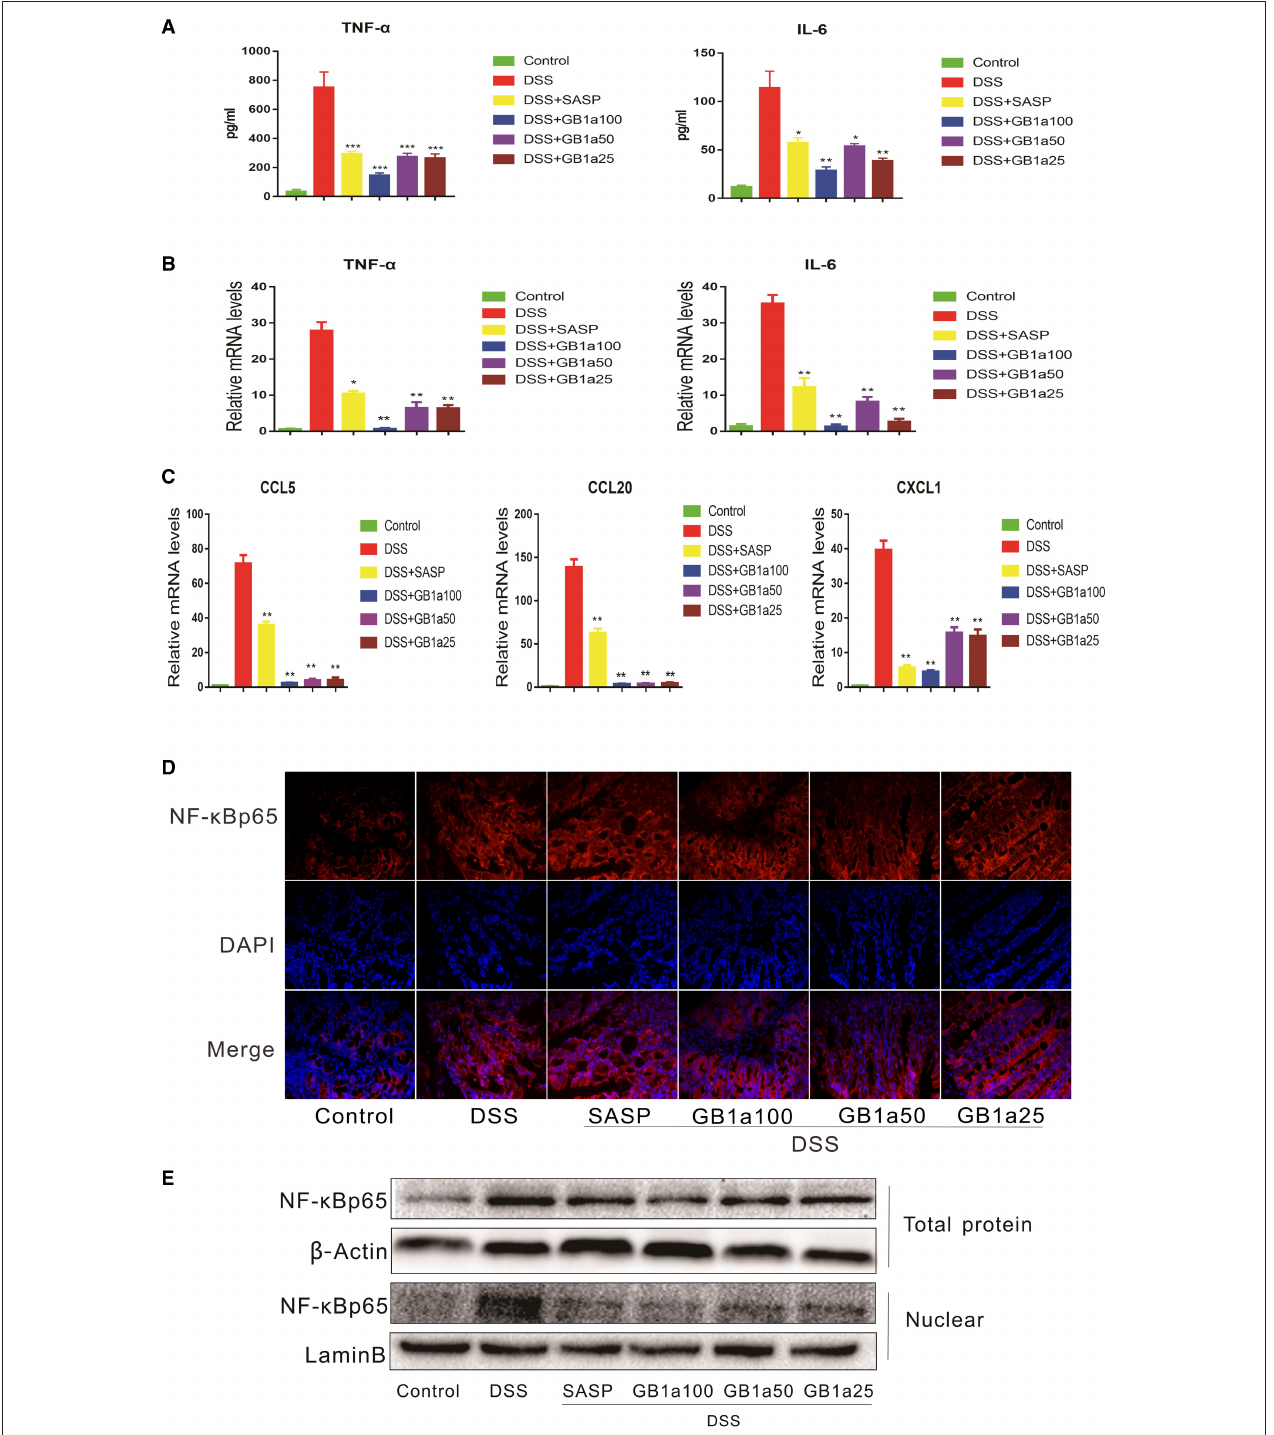
FIGURE 4 | The inhibitory effects of GB1a are dependent on the NF- κ B signaling pathway in UC mice. (A) Treatment with GB1a down-regulated serum TNF- α and IL-6 levels in UC mice. (B,C) GB1a inhibited the expression of TNF- α , IL-6, CCL5, CCL20, CXCL1 in the colon tissue of UC mice. (D) Immunofluorescence analysis of NF- κ Bp65 (red) in the colon of mice. DAPI was used for nuclear staining (blue). (E) NF- κ Bp65 levels in whole and nuclear protein were analyzed by western blotting. Data are presented as means ± SD ( n = 7/group). * p < 0.05, ** p < 0.01, and *** p < 0.001 vs. the DSS-incubated group.